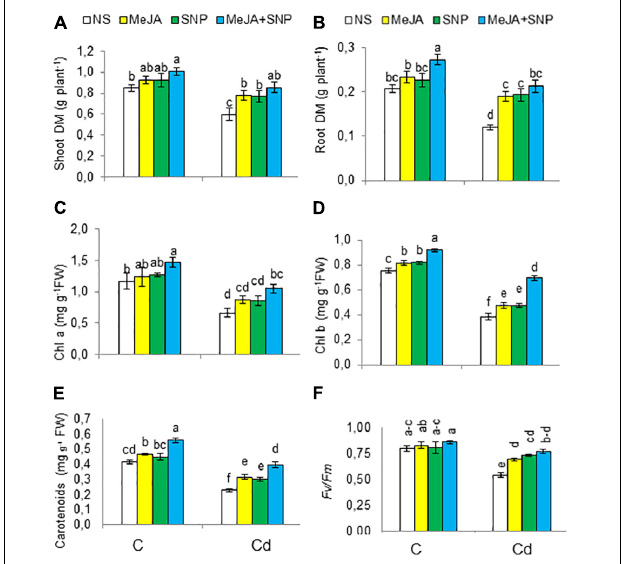
FIGURE 2 | Shoot (A) and root (B) dry weight (DW), chlorophyll a (C) , chlorophyll b (D) , carotenoids (E) on fresh weight (FW) basis, and chlorophyll fluorescence parameters [ F v / F m (F) ] in wheat plants grown under control (C) and cadmium (100 µ M Cd) and sprayed with 10 µ M methyl jasmonate (MeJA) or 100 µ M sodium nitroprusside (SNP) alone or together (mean ± SE). Mean values carrying different letters within each attribute differ significantly ( P ≤ 0.05) based on Duncan multiple-range